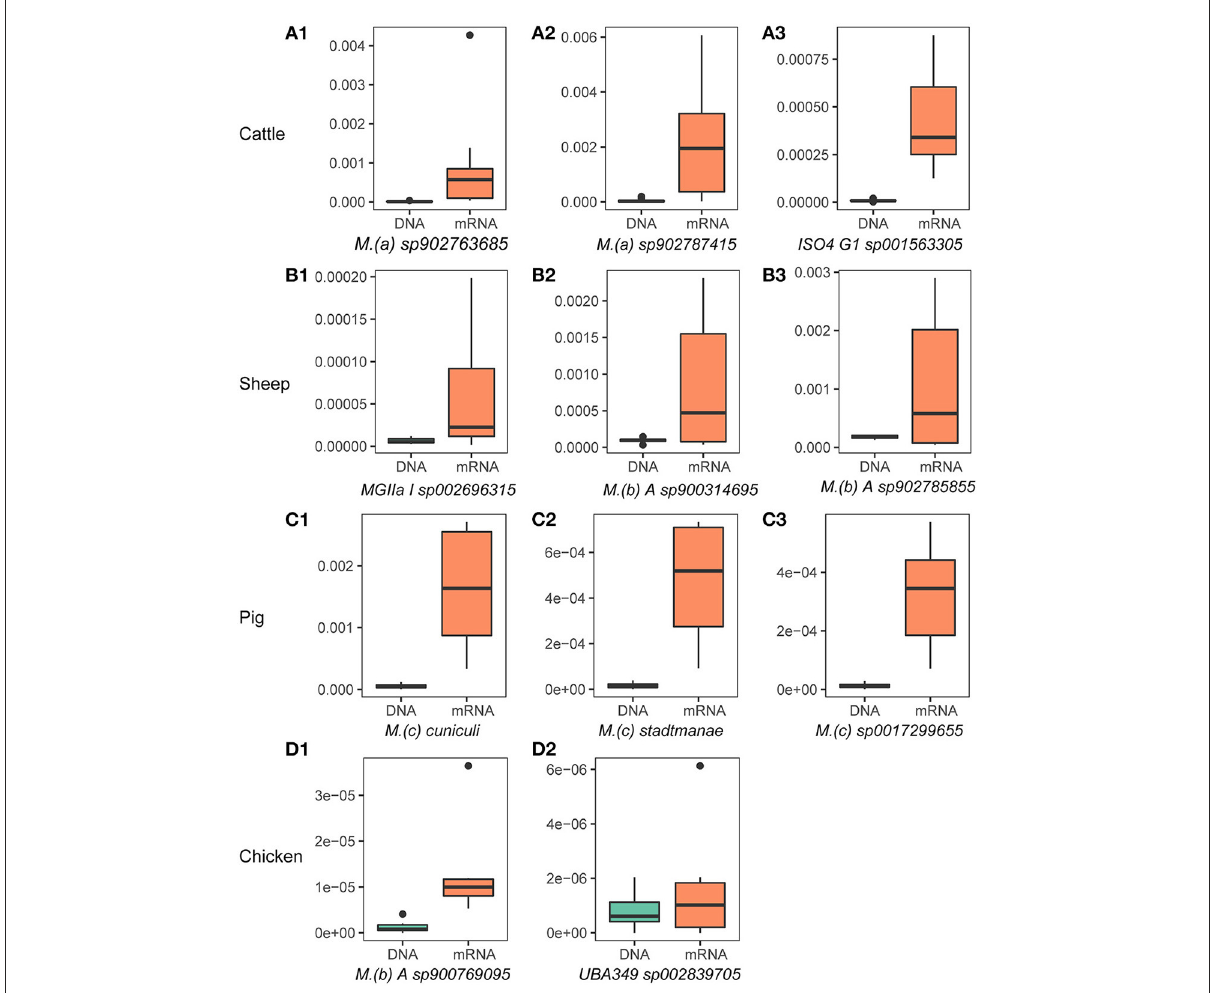
FIGURE2 Highly active archaeal species in the rumen/gut of cattle (A1–A3) , sheep (B1–B3) , pigs (C1–C3) , and chickens (D1,D2) . The y-axis represents species’ relative abundance in archaea and bacteria, and labels of DNA and mRNA on the x-axis label represent the relative abundance from metagenome and metatranscriptome, respectively. The x-axis titles are the name of archaeal species, name abbreviations of genus showed in the figure are as follows: M.(a) : Methanomethylophilus , M.(b) : Methanobrevibacter , M.(c) : Methanosphaera . ISO4 G1, MGIIa I, and UBA349 are genus names or ids defined in the